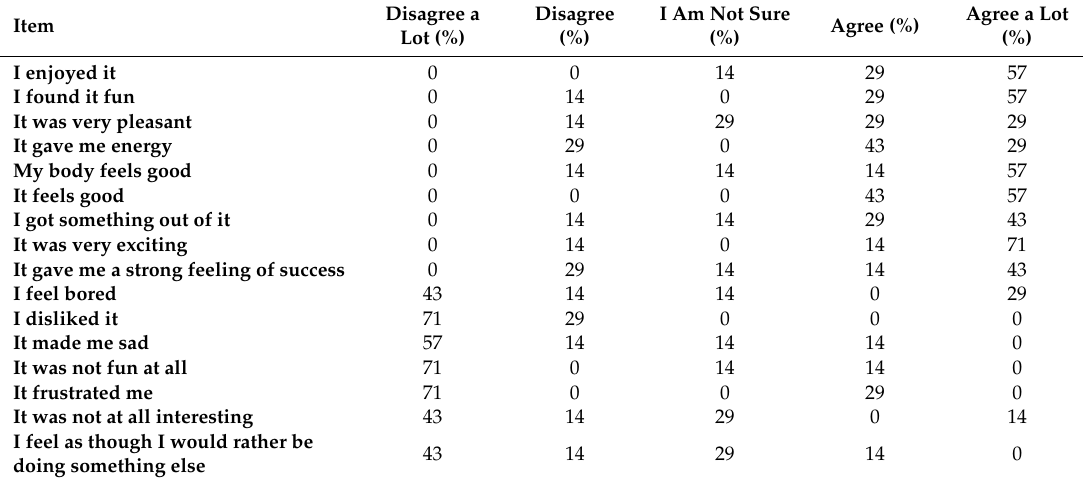
Table 1. Participant responses on the Physical Activity Enjoyment Scale (PACES) questionnaire.